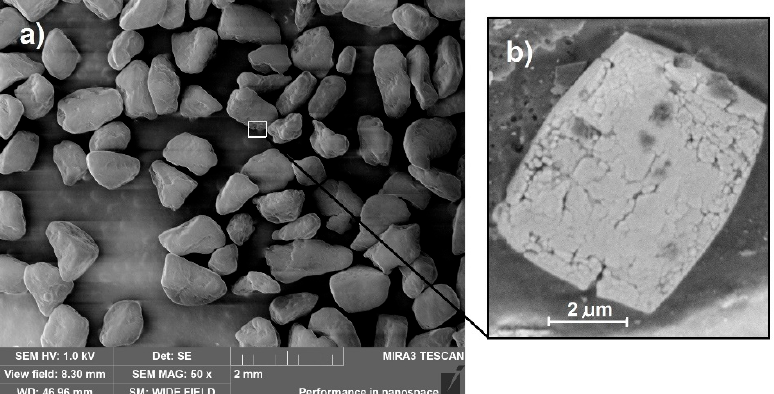
Figure 20. Abrasives for finishing. ( a ) an overview of the material (diamond grain captured in crushed walnut shells), ( b ) the diamond grain.